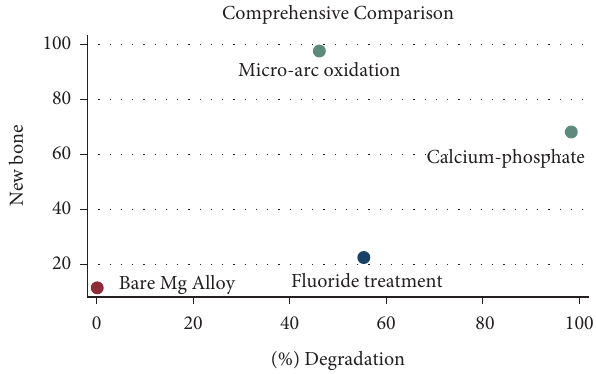
Figure 14: Comprehensive comparison of different